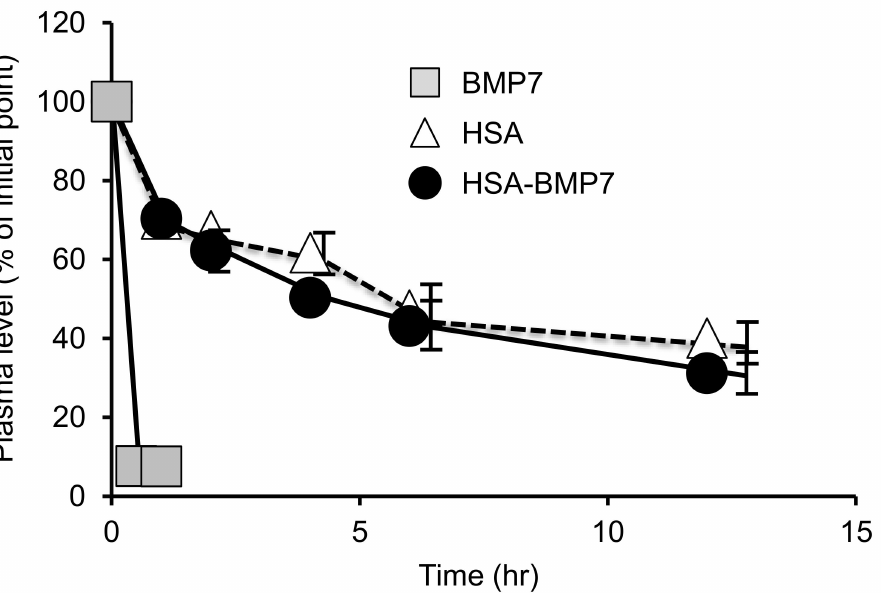
Figure 3. Plasma level of 125 I-labeled HSA-BMP7, HSA or BMP7 after intravenous administration to mice. 125 I-labeled proteins were injected through the tail vein of the mice. Results are the means ± SD ( n =